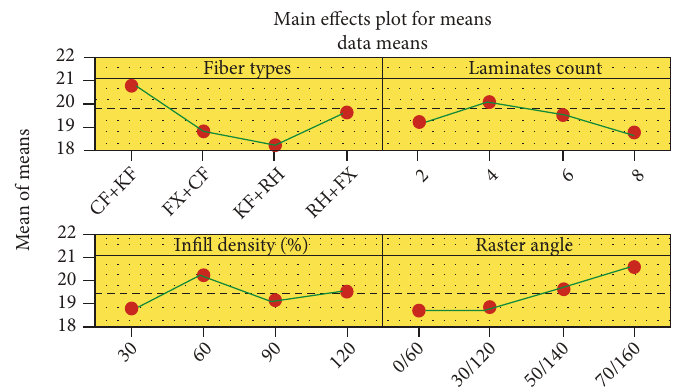
Figure 4: Main e ff ect plot for means ( fl exural strength).